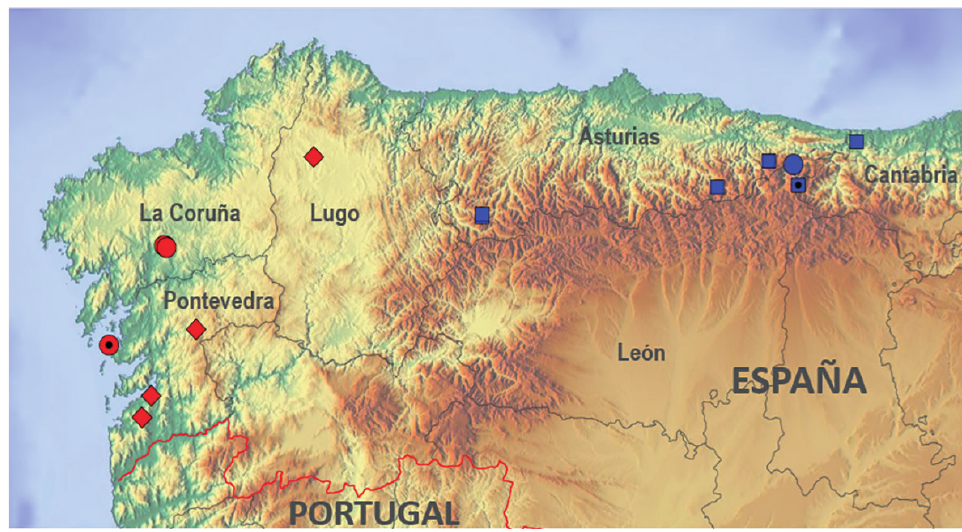
Fig. 13. Map of the northwestern part of the Iberian Peninsula with the known distribution of Dicranopalpus gallaecicus sp. nov. (red symbols) and Dicranopalpus cantabricus Dresco, 1953 (blue symbols). Dots: studied samples; squares: literature records; diamonds, photographic records. Type localities are indicated by a